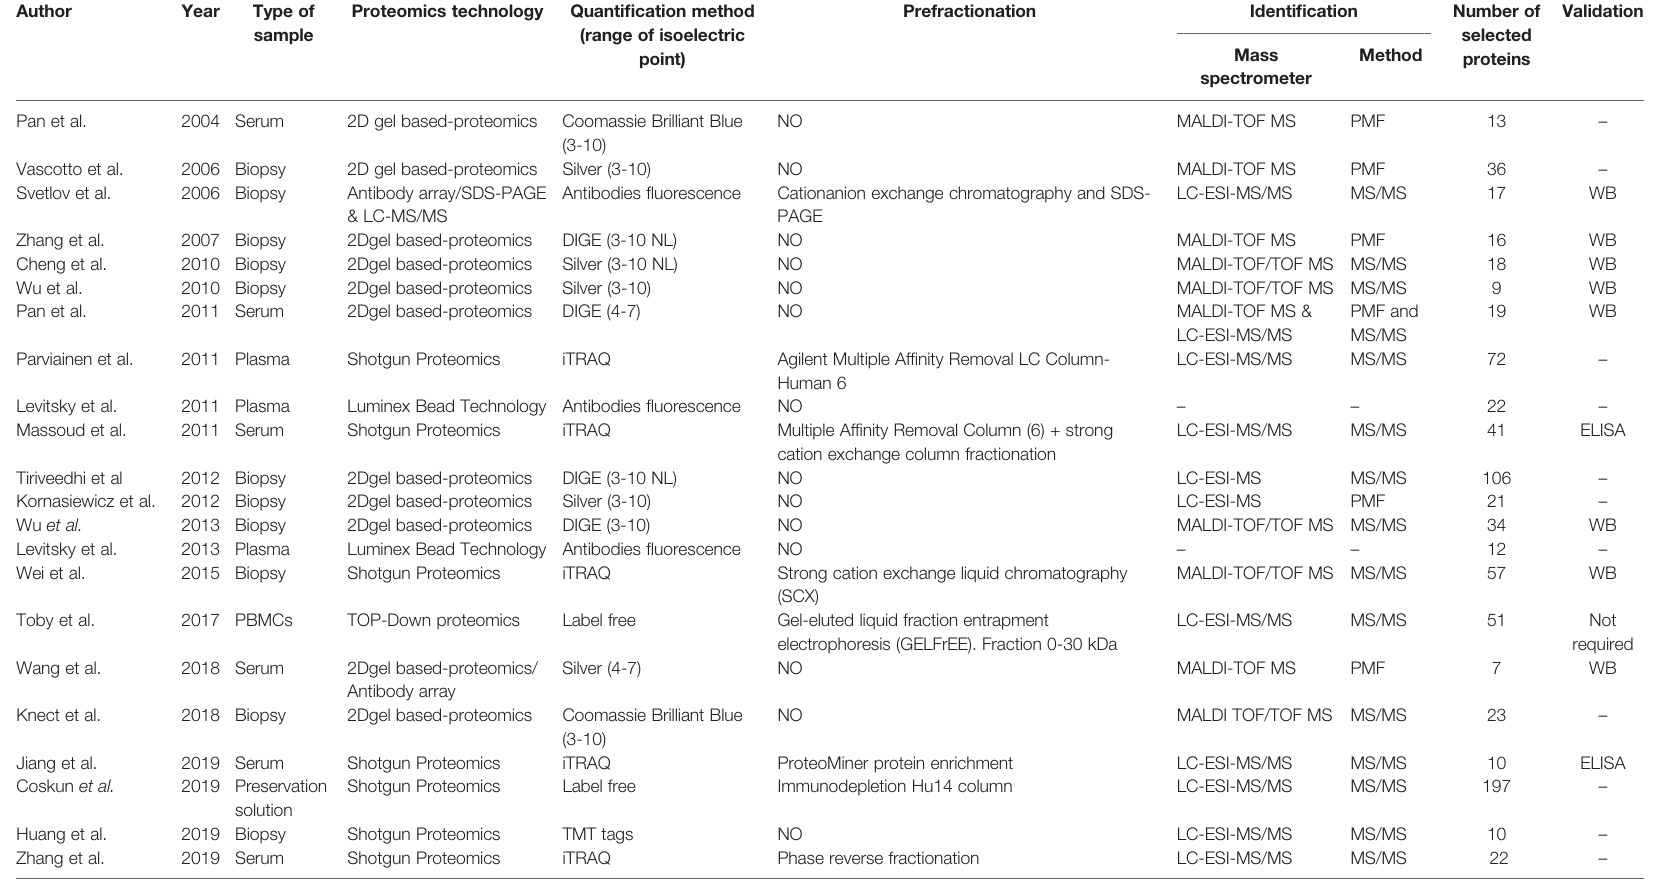
SDS-PAGE,Sodiumdodecyl sulfate-polyacrylamide gelelectrophoresis; 2Dgel,Two-dimension gelelectrophoresis;DIGE, Differentialingelelectrophoresis; iTRAQ,Isobarictagsforrelativeandabsolute quantitation;TMT tag,Tandemmass tagsystem;MALDI,Matrix-assistedlaserdesorption/ionization;TOF,Time-of- fl ight;LC-,Liquidchromatography;ESI,Electrosprayionization;PMF,Peptidemass fi ngerprinting;MS/MS,Tandemmassspectrometry;WB,Westernblot;ELISA, Enzyme-linked immunoSorbent